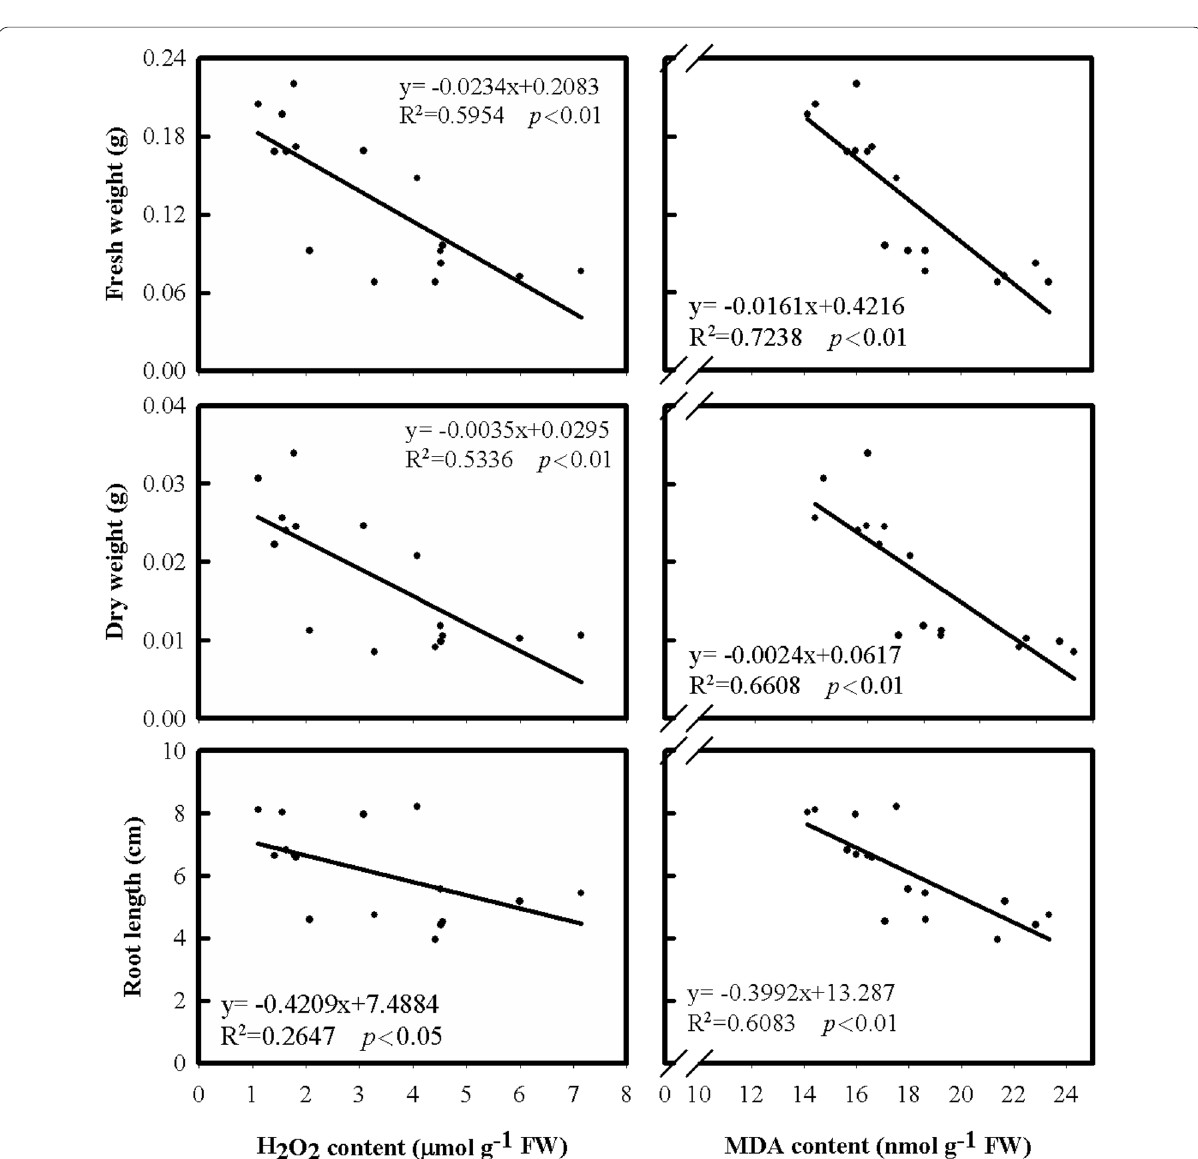
Fig. 4 The relationships of root H 2 O 2 and MDA contents with root fresh weight, dry weight and length under cold treatment among eight rice cultivates. The temperature was set at 15 °C for cold treatment and 27 °C for control. After 4 days of treatment, the temperature was adjusted to 27 °C for 3 days before